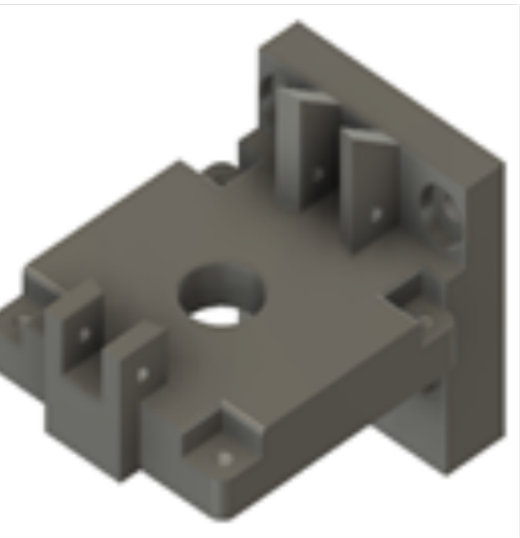
Figure 4. The model of the motor support. The motor support is located at the bottom of the servo motor shown in Figure